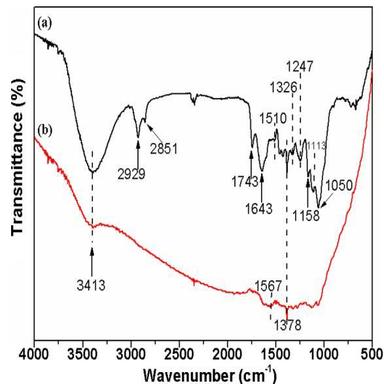
The FTIR spectra of (a) native (raw) and (b) carbonized (850 °C) Poplar fluff samples.